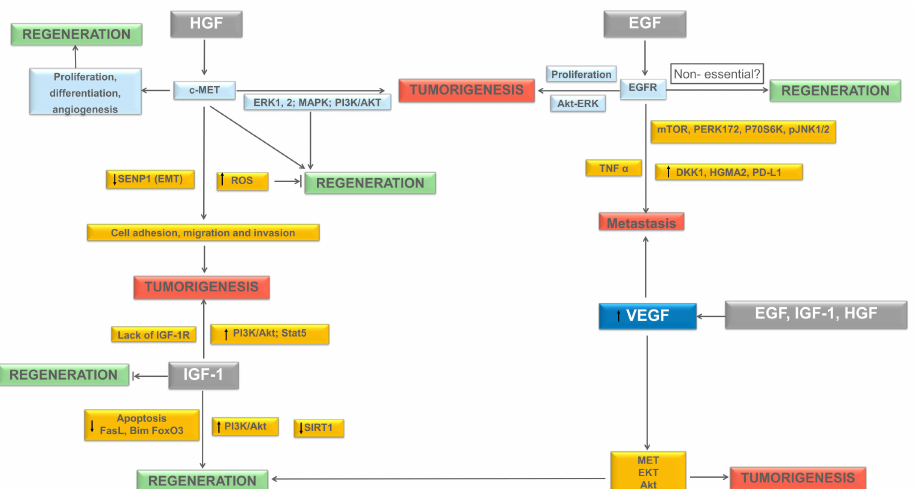
Figure 2. Molecular pathways underlying liver regeneration and tumorigenesis. Proposed pathways of HGF, EGF, IGF-1, and their link to VEGF in inducing regeneration and/or tumorigenesis. Abbrevi- ations: Akt, Protein kinase B; c-Met, Mesenchymal–epithelial transition factor; DKK1, Dickkopf-1; ECM, Extracellular matrix; EGF, Epidermal growth factor; EGFR, Epidermal growth factor receptor; ERK, Extracellular signal-regulated kinase; FasL, Fas Ligand; FoxO3a, Forkhead box protein O3a; HGF, Hepatocyte growth factor; HMGA2, High-mobility group protein A2; IGF-1, Insulin-like growth factor 1; IGF-1 R, Insulin-like growth factor receptor; MAPK, Mitogen-activated protein kinase; MET, Mesenchymal–epithelial transition factor; mTOR, mammalian target of rapamycin; PERK, protein kinase R-like endoplasmic reticulum kinase; PI3K, Phosphoinositide 3-kinase; PD-L1, Programmed death-ligand 1; ROS, Reactive oxygen species. SIRT1, Deacetylase sirtuin1; STAT, Signal transducer and activator of transcription; TNF α , Tumor necrosis factor-alpha; VEGF, Vascular endothelial growth factor. → : induce the expression; → : blockadge of expression; ↑ : increment; ↓ : (cid:91)